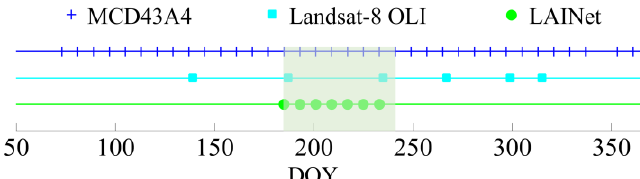
Figure 2. Temporal distributions of the MODIS and Landsat acquisitions during the year 2013 over the study area. The shaded area represents the period of acquisition of ground LAINet measurements. DOY: day of year.